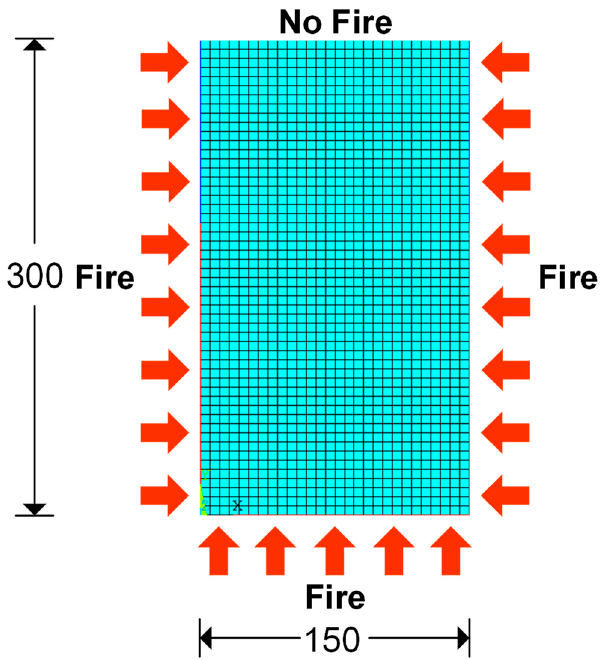
Figure 13. Concrete beam, 2D (units in millimeters).